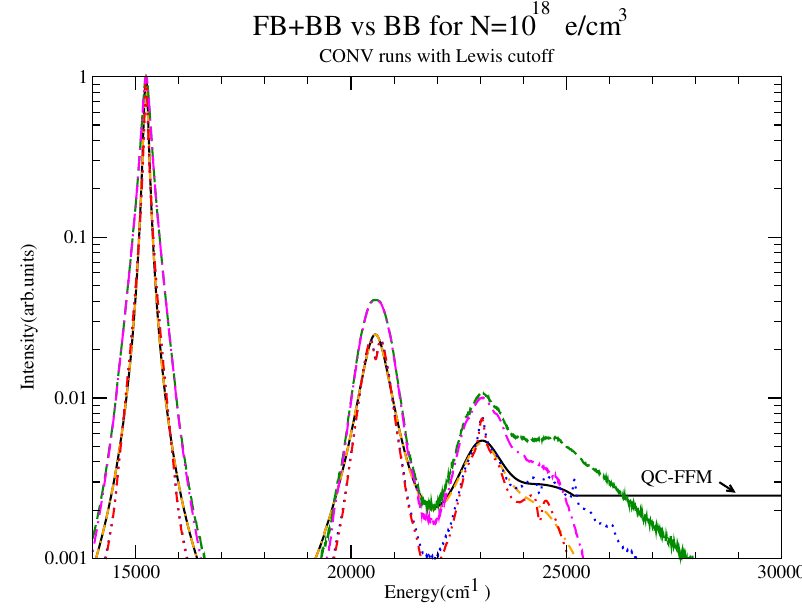
Figure 30. BB + FB vs. BB comparison for the intermediate density close to the continuum. Shown are QC-FFM for BB + FB (solid black) and BB only (dot-double dashed orange), CONVST for BB + FB (dashed green) and CONVST for BB only (dash-dotted magenta) and CONVPST for FB + BB (dotted blue) and BB only (dash-double dotted red). The CONV runs include strong collisions and the Lewis cutoff. The Inglis-Teller cutoff was used in the BB only CONV